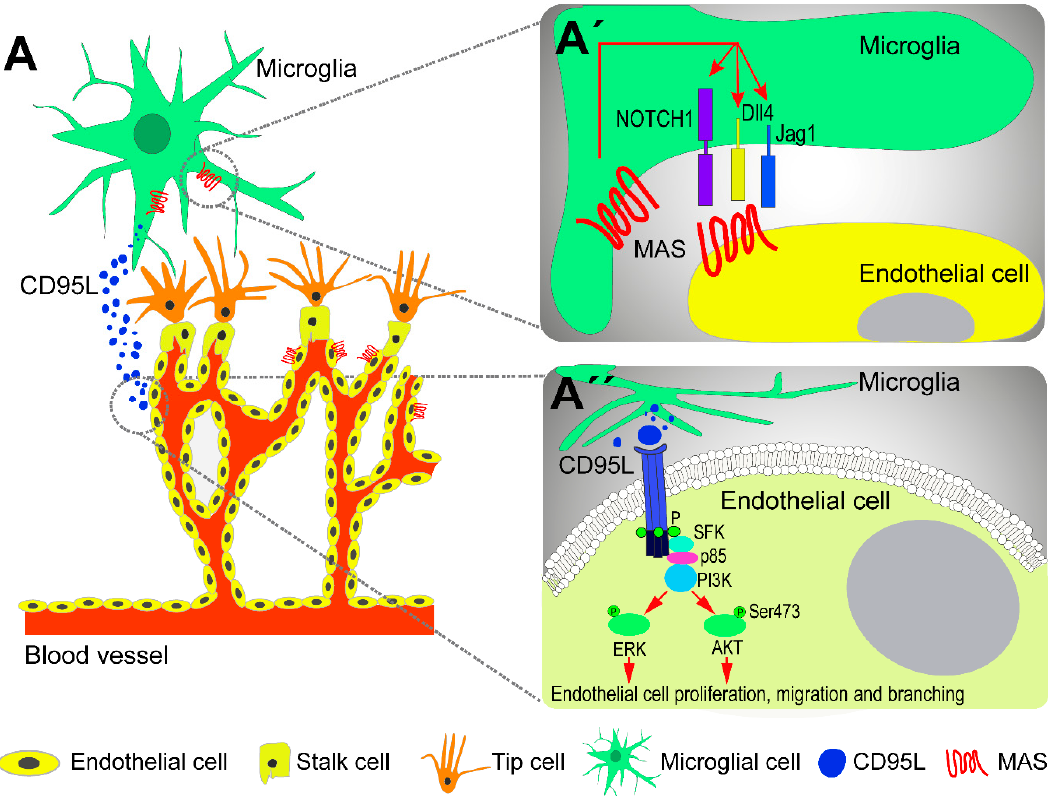
Figure 1. Contribution of microglial cells to vascular development in the retina. ( A ) The activation of the MAS receptor is involved in the recruitment of microglia and vascular growth in the developing retina by activating the Notch signaling pathway. ( A’ ) Microglial cells secrete CD95L that binds to its receptor CD95 on endothelial cells. The phosphorylation of the death domain by Src-family kinase results in the activation of PI3K signaling pathways, leading to the activation of AKT or ERK ( A”